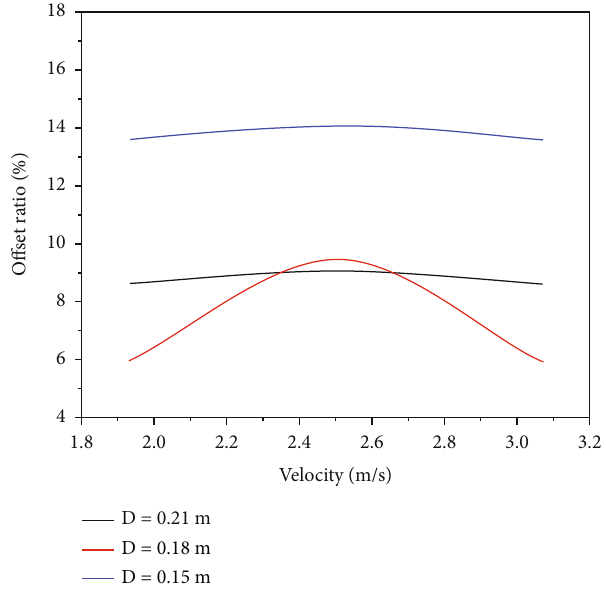
Table 3: Coded run scheme.